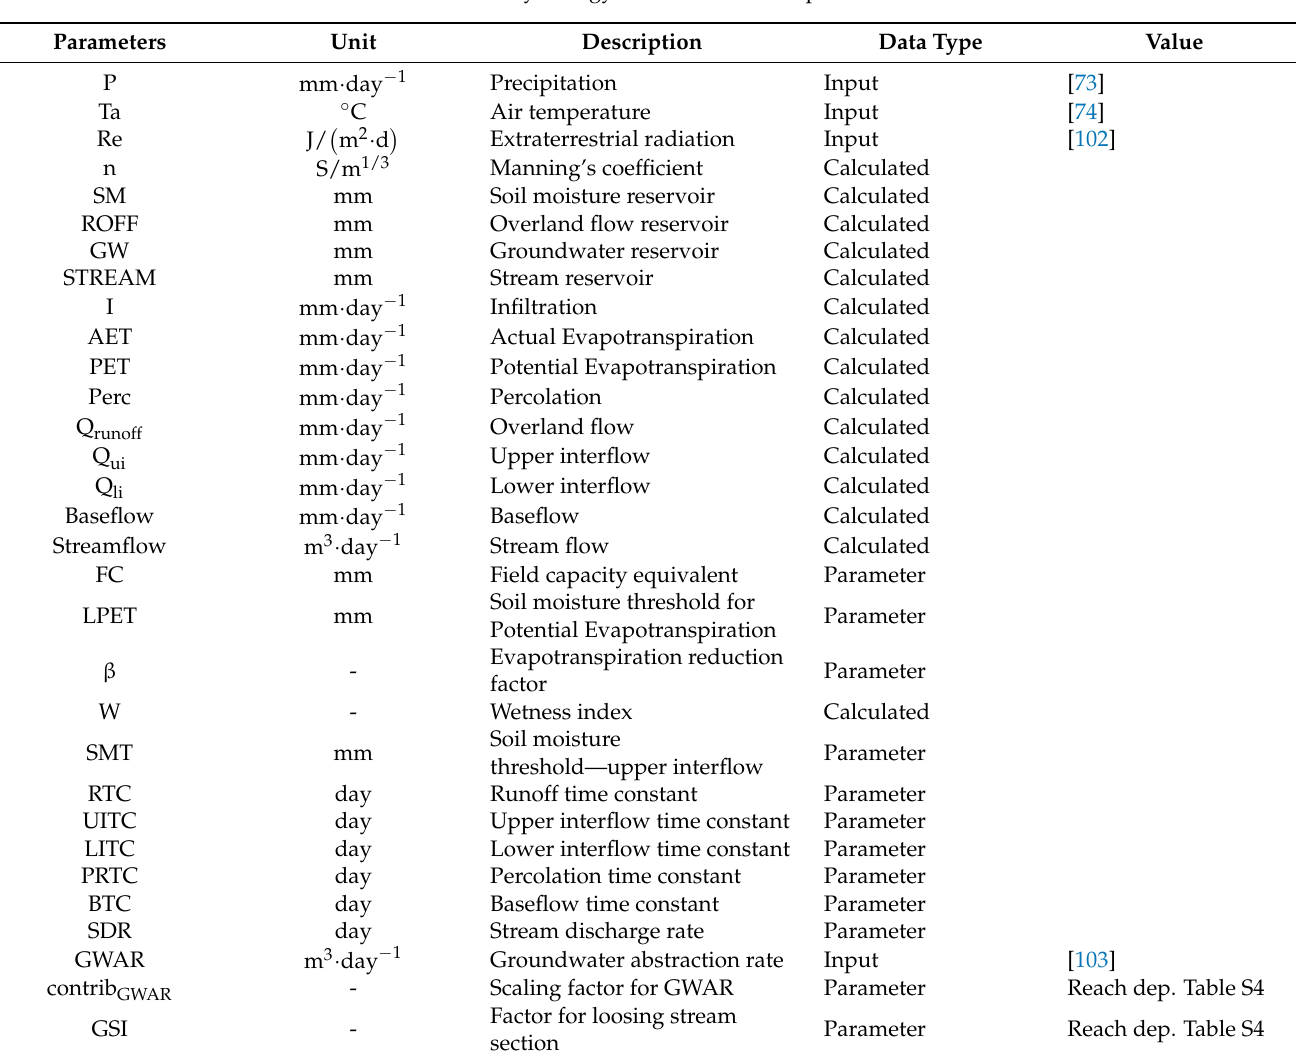
Table A2. Hydrology—natural flow